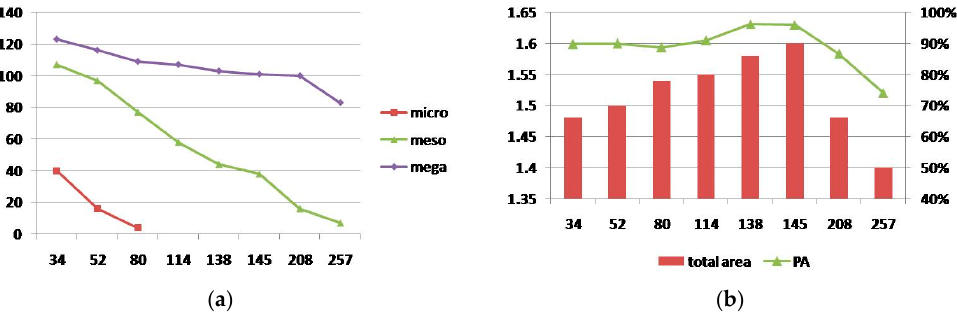
Figure 7. ( a ) The relationship between the total number of three types of yardangs under the different segmentation scales, ( b ) The relationship between the producer’s accuracy and the total area of yardang